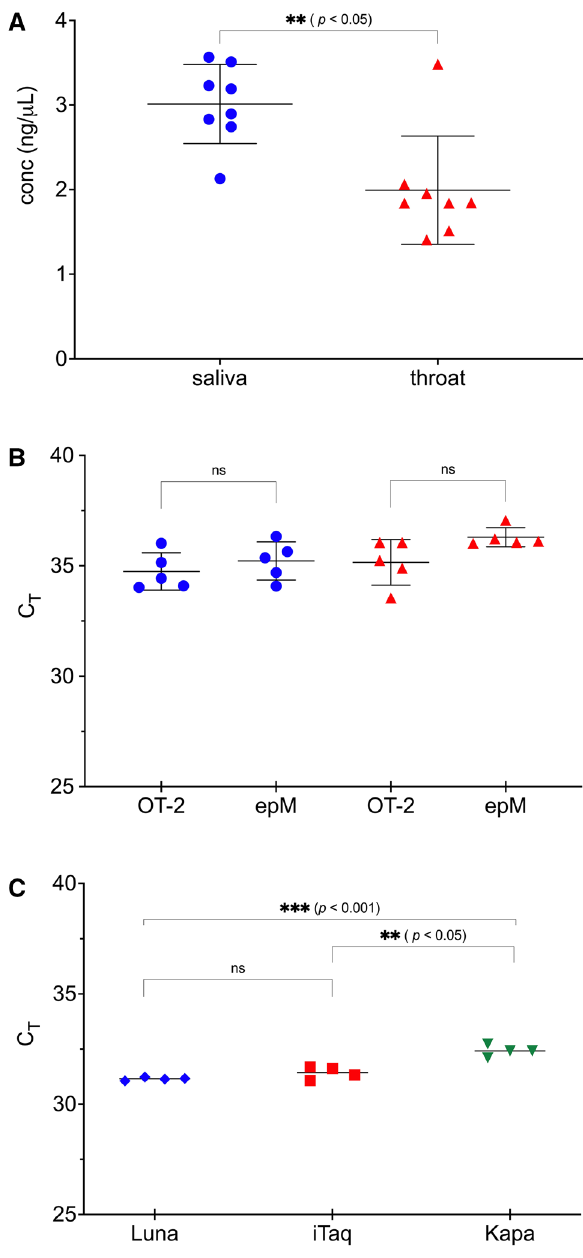
Figure 2. Efficacy of TRIzol RNA isolation from saliva and throat swabs using automated liquid handlers. ( A ) Concentration of RNA of saliva (blue circle) and throat swabs (red triangle) determined using Quant-IT. ( B ) Threshold cycles (C T ) of one-step RT-qPCR analysis on total RNA extracted from saliva (blue cirlce) and throat swabs (red triangle) using Opentron-2 (OT2) and Eppendorf epMotion (epM). Analysis targeting human Ribonuclease P (RNase P) was performed on five technical replicates. ( C ) Detection of RNase P using multiple qPCR master mixes. Analysis was performed with Luna (NEB; blue diamond), iTaq (Bio-Rad; red square) and KAPA (Kapa Biosystems; green inverted triangle) one-step SYBR RT-qPCR kits. Total RNA was extracted from throat swabs using Eppendorf epMotion. Statistical differences were analysed using unpaired, two-tailed t-test where ns indicates non-significance ( p >